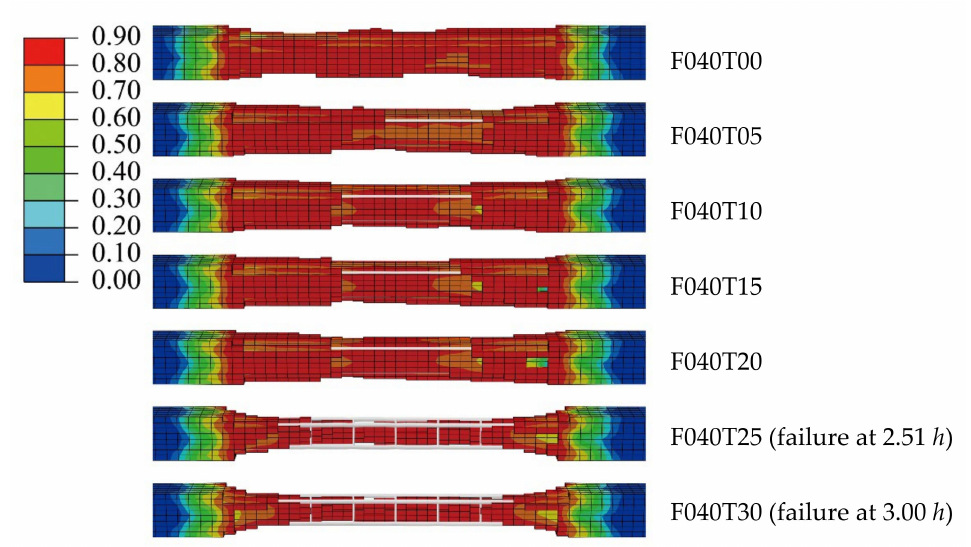
Figure 17. Damage of RC column with different TP and amplitude of 0.40.